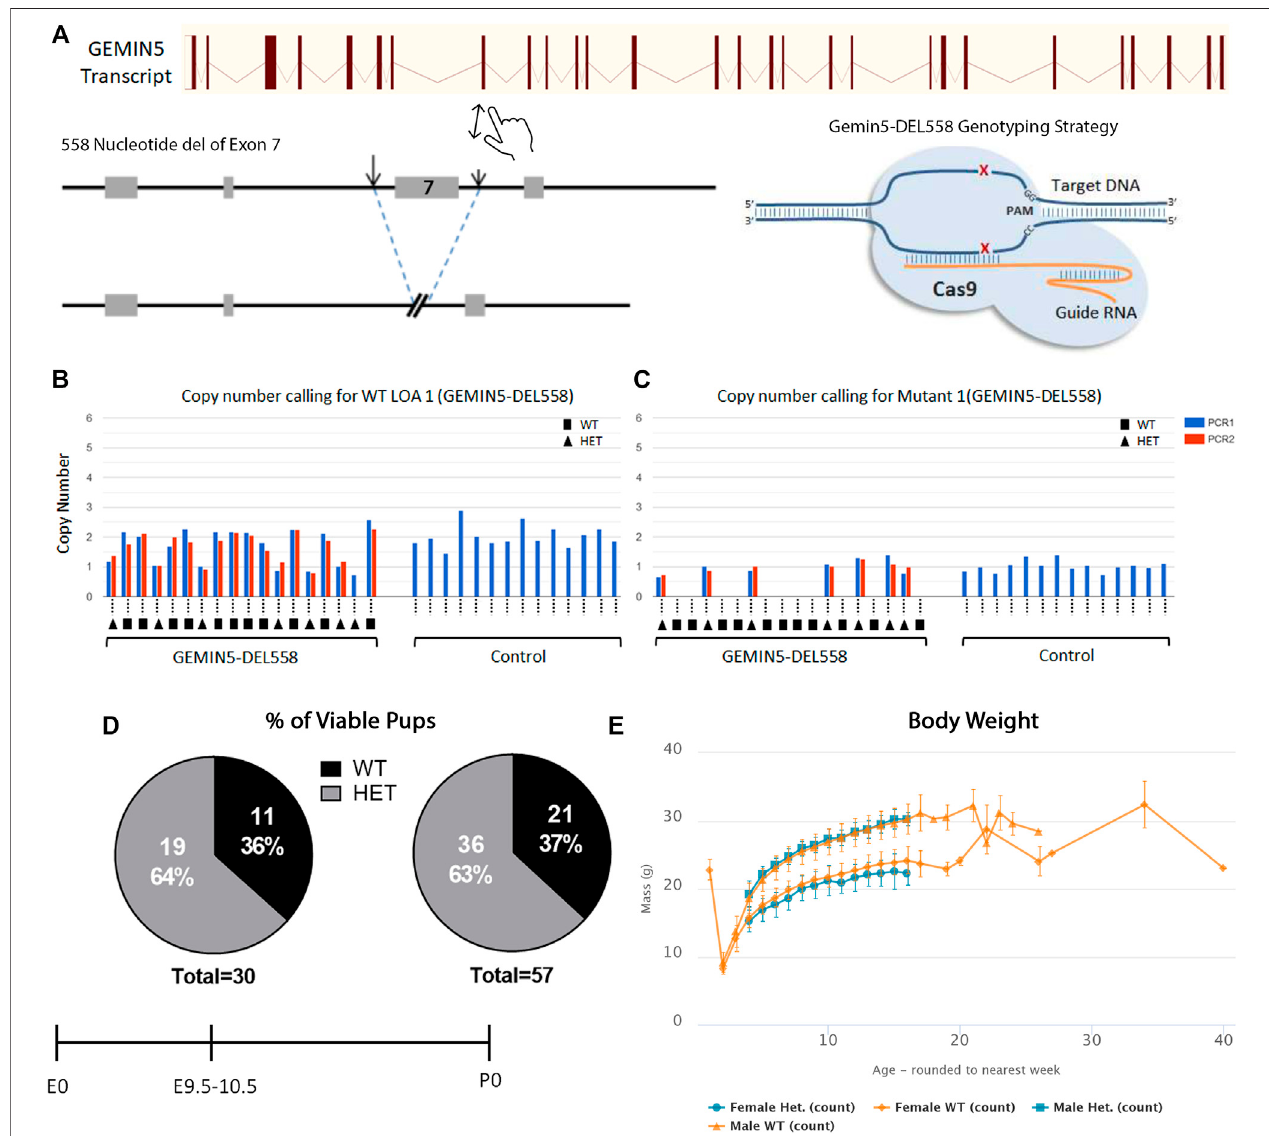
FIGURE5| KnockoutofGemin5leadstoearlyembryoniclethalityinmice. (A) Schematicrepresentationofthewild-typealleleofthemouse Gemin5 transcript.The Gemin5 KO mouse (GEMIN5-DEL558) was created by utilizing the EUCOMM/KOMP-CSD allele structure to delete 558 nucleotides from exon 7 of the Gemin5 gene, encompassing a critical exon to induce a premature stop codon and a null Gemin5 allele (Mianné et al., 2017). (B) SR-PCR genotyping detects the presence of the Gemin5 wild-type allele by short-range PCR in Gemin5 KO and control mice (copy number of 2). Samples are genotyped with a WT loss of allele (WT-LOA) assay. This is a FAM-labeled assay that is designed to detect the critical exon that has been fl oxed. If the animal contains 1 Gemin5 KO allele, the copy number of this assay shoulddropby1(copynumberof1).Forautosomalgenesthathavebeentargeted,thismeansthefollowing:WT = 2copiesoftheLOAassay,HET = 1copyoftheLOA assay, HOM = 0 copy of the LOA assay. (C) SR-PCR genotyping detects the presence of the cassette lacZ, the Gemin5 wild-type allele, and the Gemin5 KO allele con fi rming heterozygotes by short-range PCR (copy number of 1). (D) Viability of Gemin5 KO mice at the embryonic stage of E9.5 and as fi rst-born pups at P0. Homozygous Gemin5 KO mice are not viable up to the embryonic stage of E9.5. (E) A body composition (DEXA lean/fat) phenotypic assay was performed on 1,028 mice. The charts show the results of measuring lean mass in 8 Het females and 7 Het male mice compared with 514 female and 499 male controls. Heterozygote mice appear to have no change in body mass compared with